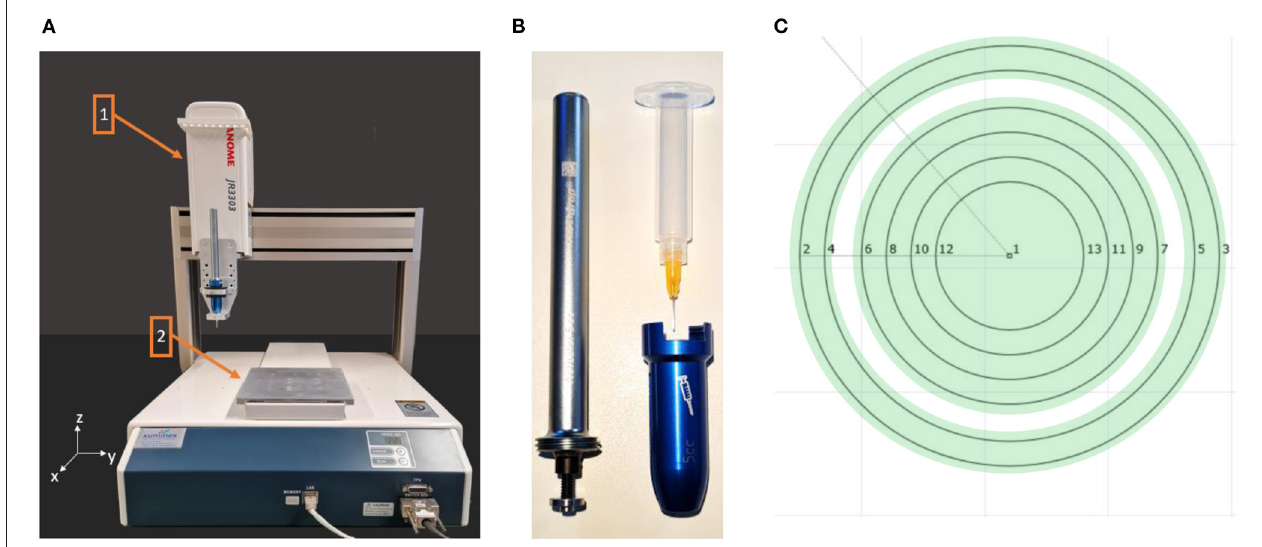
FIGURE 1 | (A) The upper part (1) of the dispensing robot moves in y- and z-direction while the positioning table (2) moves in x-direction. (B) The dosing unit consists of the volumetric dispenser with the cartridge and a dosing cannula. (C) The stepwise travel path of the dispensing unit defined in the JR C-Point II V8 software for masking the surfaces (green) of the lens, which should not be